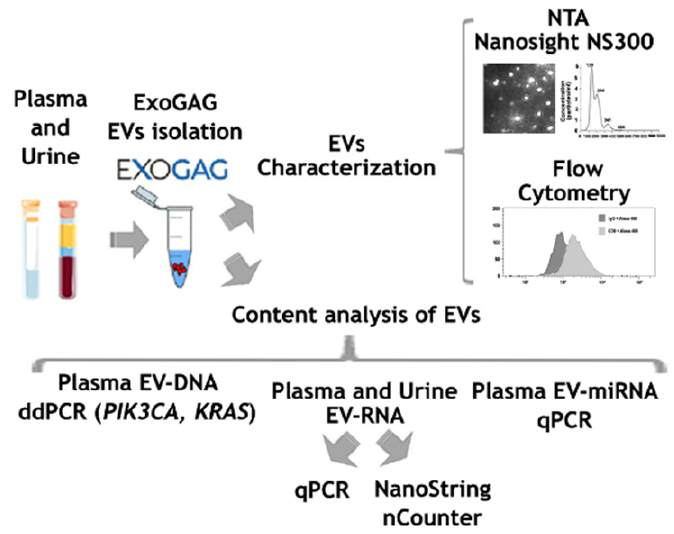
Figure 1. Scheme showing the steps followed for the characterization of EVs isolated with ExoGAG from plasma and urine samples.